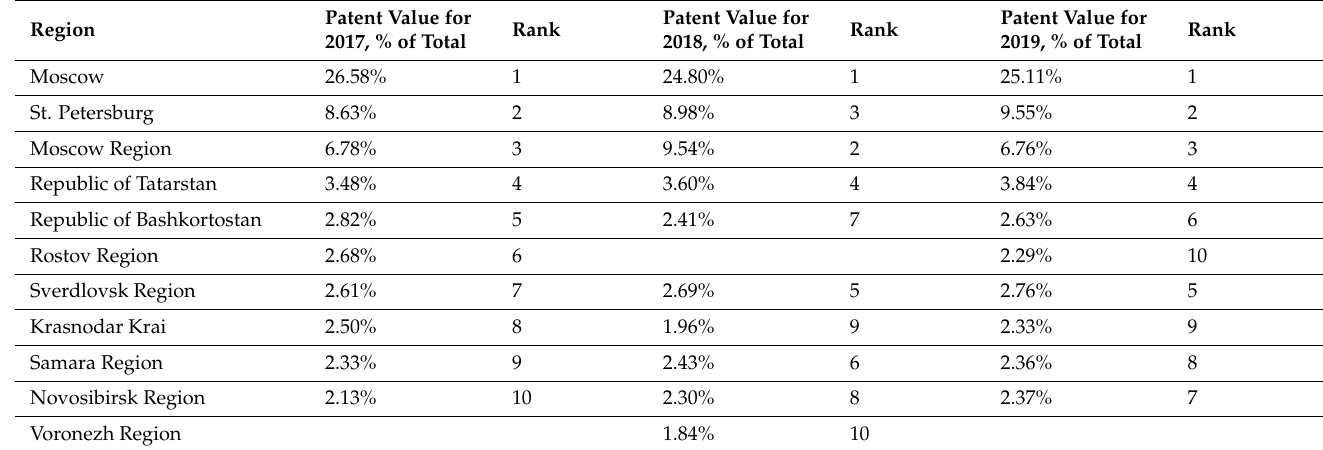
Table 9. Top 10 regions with the highest indicator for patents for